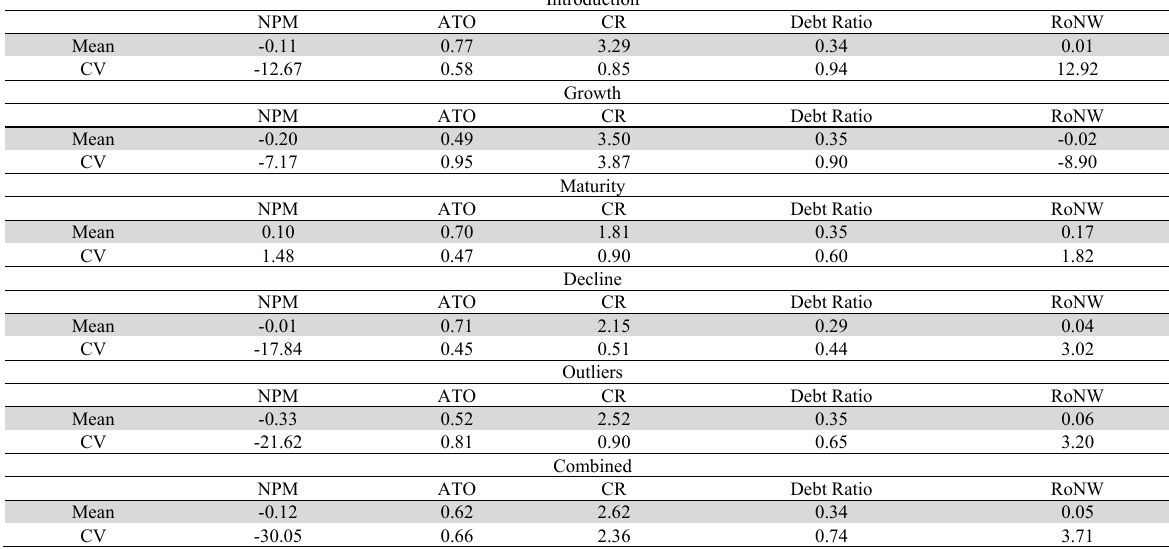
were observed to perform worst in terms of profitability (NPM and RoNW). This was further explained by a positive crisis dummy independent variable in panel 3 (Eq. (5)). It was observed that for some of the growth stage companies the profitability was poor in the pre-2008 (pre financial crisis) time period which brought down the average NPM and average RoNW to negative levels. Table 4 Descriptive statistics for various growth stages